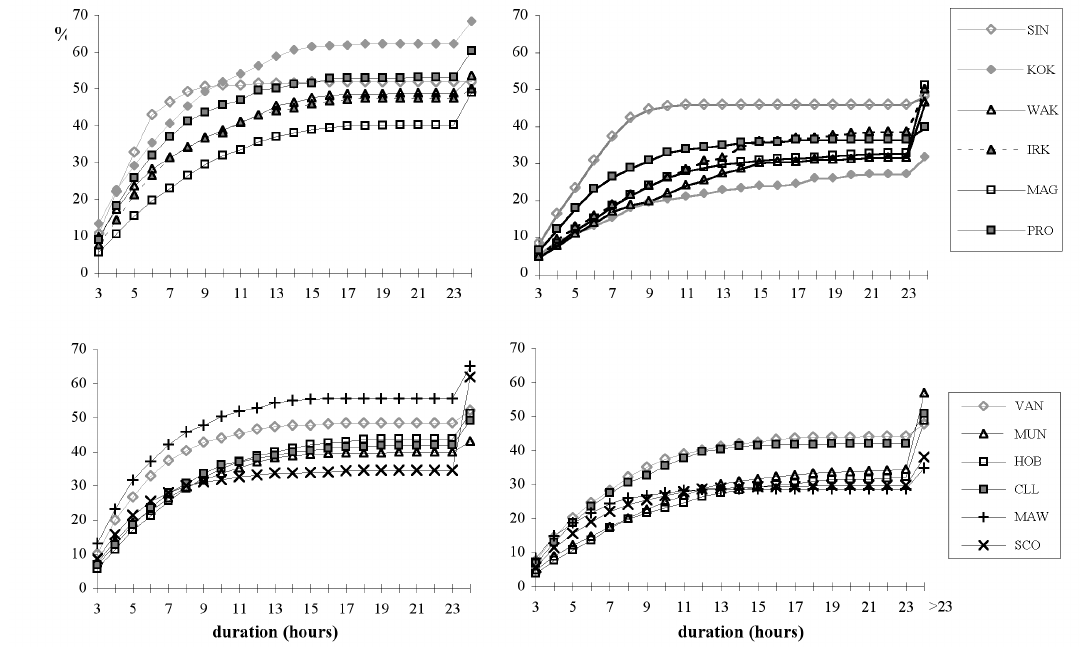
Fig. 1. Percentage of positive ( left ) and negative ( right ) disturbances for which the corresponding duration is not exceeded (cumulative distribution). Top : Asian stations; bottom : Australian